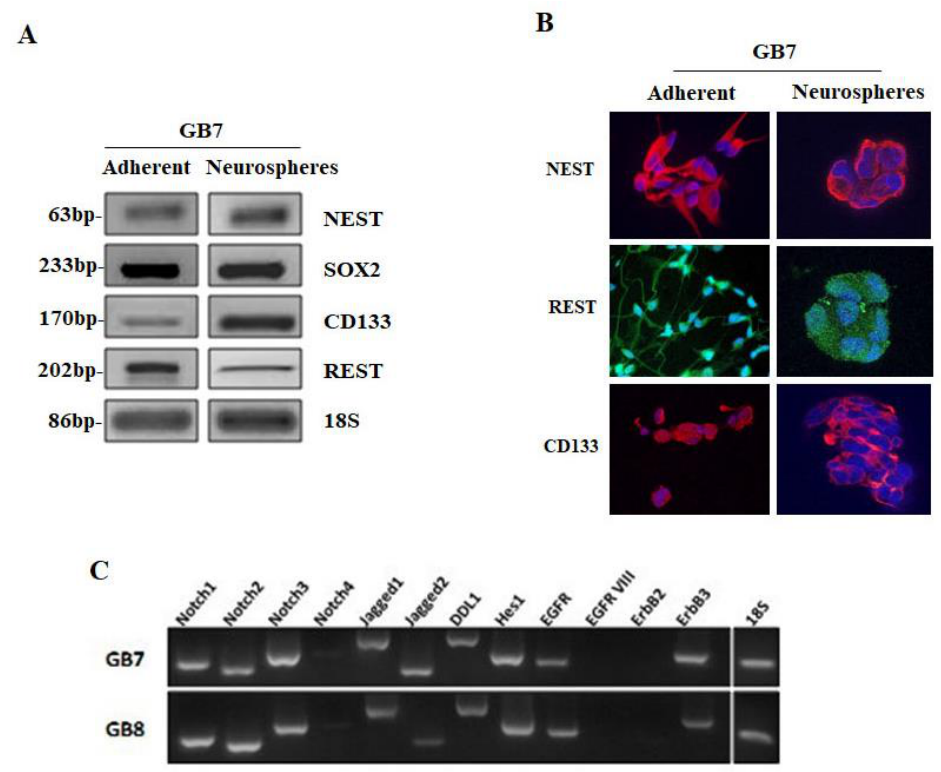
Figure 2. GB7 cells grown in adherent and as neurospheres. ( A ) RT-PCR analysis of stemness markers Nestin (NEST), SOX2, CD133, and REST. 18 S was used as a housekeeping gene. ( B ) Immunostaining for NESTIN, REST and CD133 in GB7 cells grown as a monolayer and as neuropheres in floating conditions (magnification × 100). ( C ) RT-PCR analysis for gene expression for di ff erent genes involved in Notch and EGFR pathways in GB7 and GB8 cells. 18 S was used as a housekeeping gene.